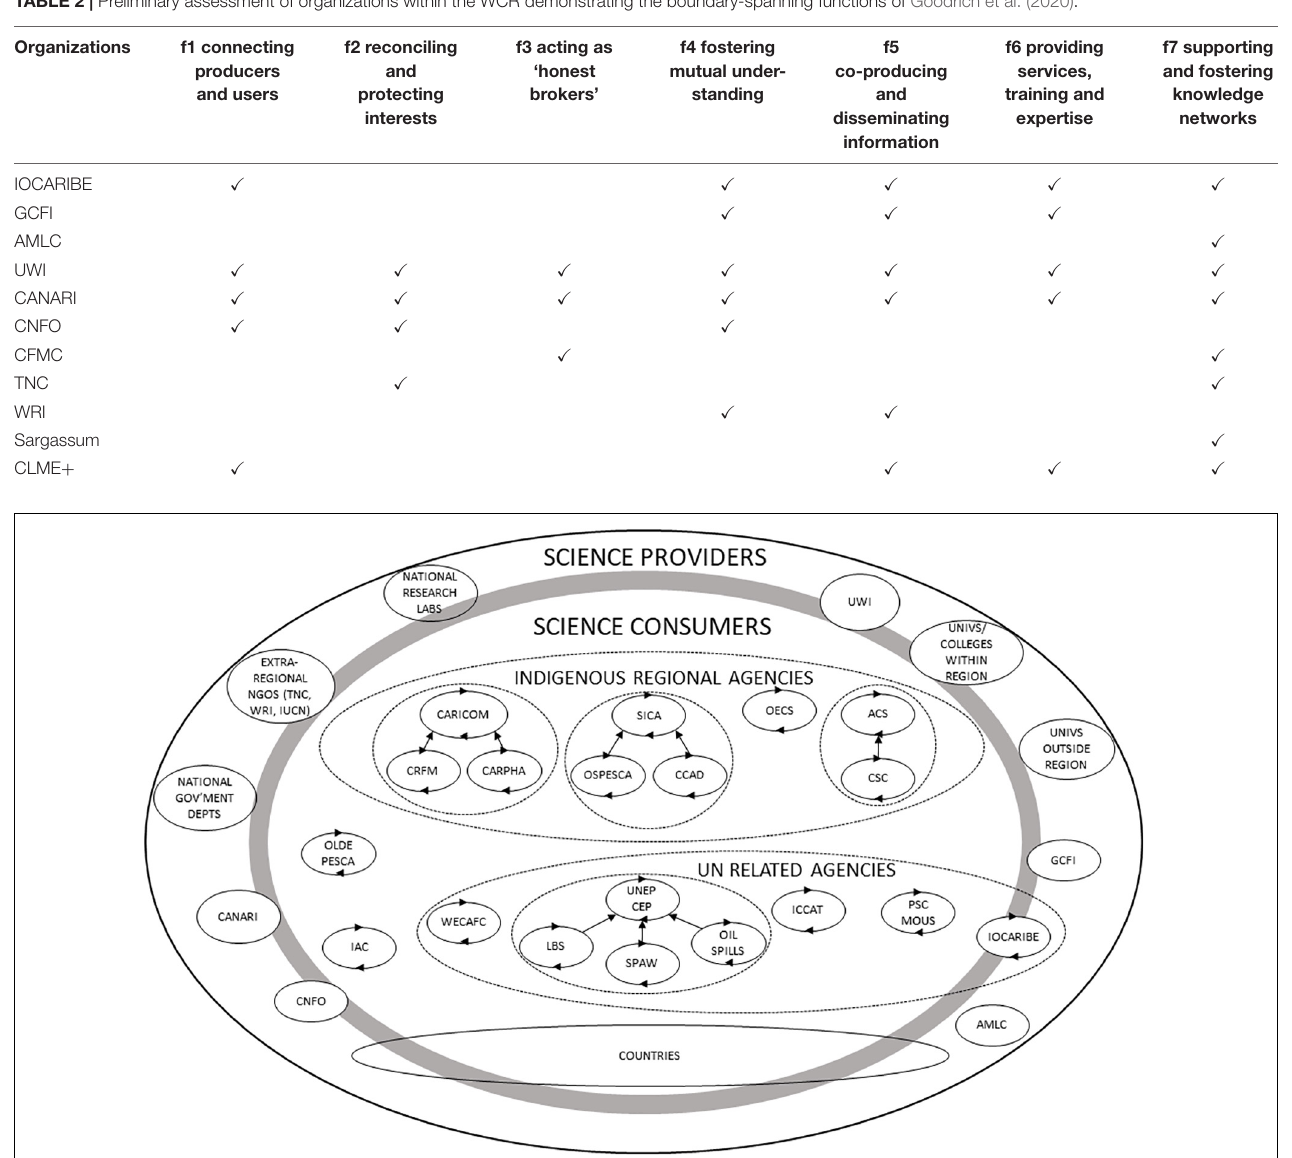
FIGURE 2 | The organizations involved in regional science-policy arenas for ocean governance in the WCR. The gray ellipse is the boundary between science producers and science consumers. Arrows on ellipses indicate science-policy